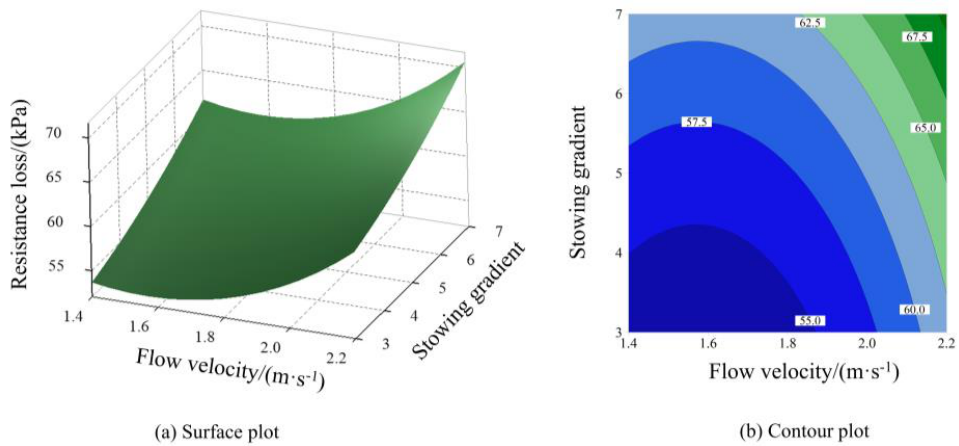
Figure 13. Interaction of inlet velocity and stowing gradient with resistance loss: the other factor is held at the center level.